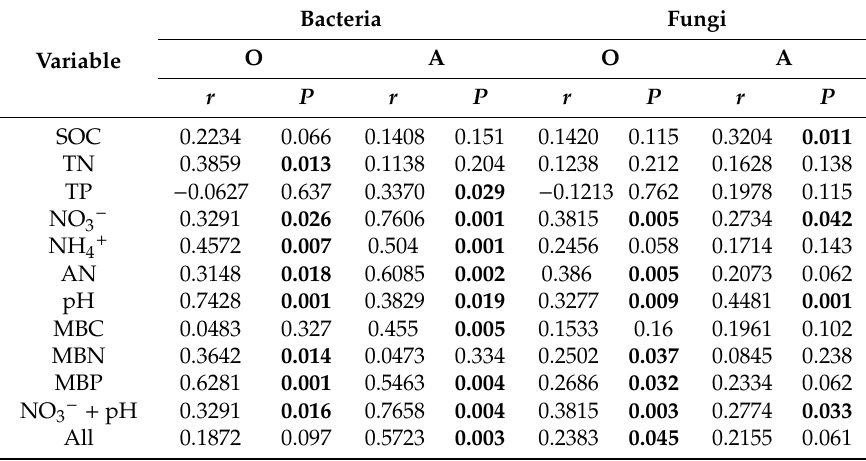
Figure 3. Redundancy analysis (RDA) of the bacterial ( a , c ) and fungal ( b , d ) community compositions and soil variables. OC, ON, OP and ONP indicate the O horizon soils (0–5 cm, ( a , b )) under control (C, without N and P addition), N addition, P addition and NP addition, respectively. AC, AN, AP and ANP indicate the A horizon soils (5–15 cm, ( c , d )) under control (C, without N and P addition), N addition, P addition and NP addition, respectively. Table 3. The correlation between microbial community structure and soil variables as determined by the Mantel test (permutation = 999). The r and P indicate Pearson correlation coefficient and significance respectively, and p values in bold indicated significant correlations.